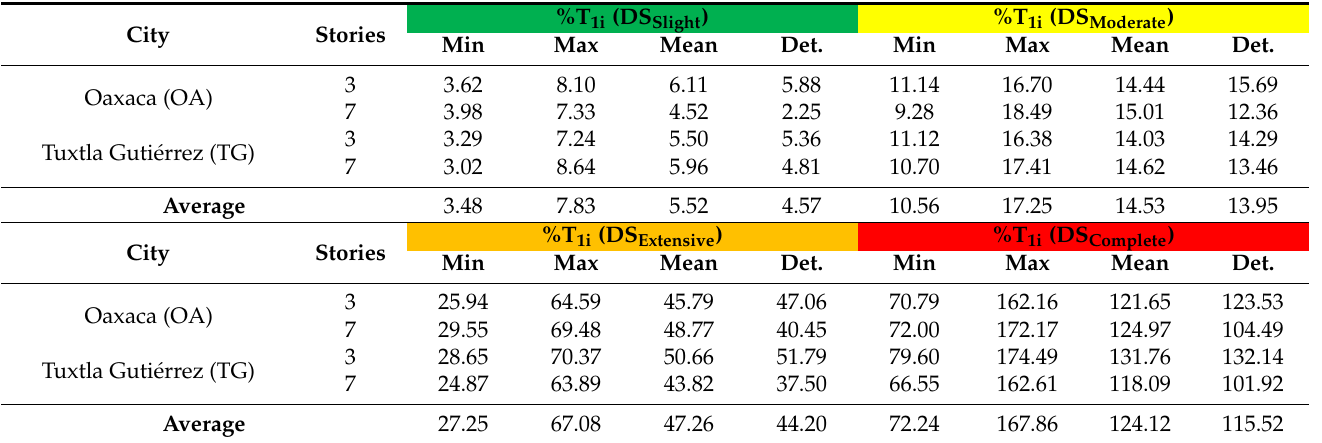
Table 8. Minimum, mean, maximum probabilistic, and deterministic value of the %T 1i for each DS non-null from the Risk-UE guideline in the